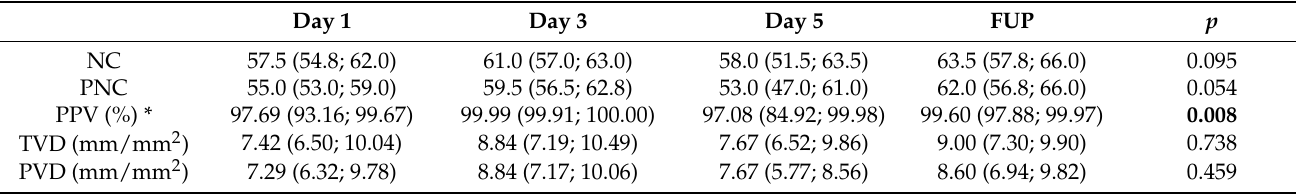
Table 4. Chronological sequence of MC parameters in MI patients.